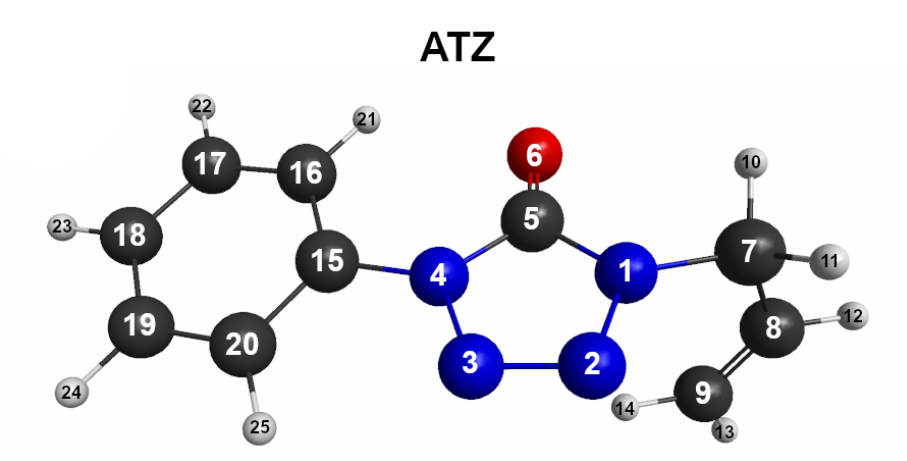
Figure 2. Singlet ground-state optimised ATZ molecule with the adopted atom labelling.